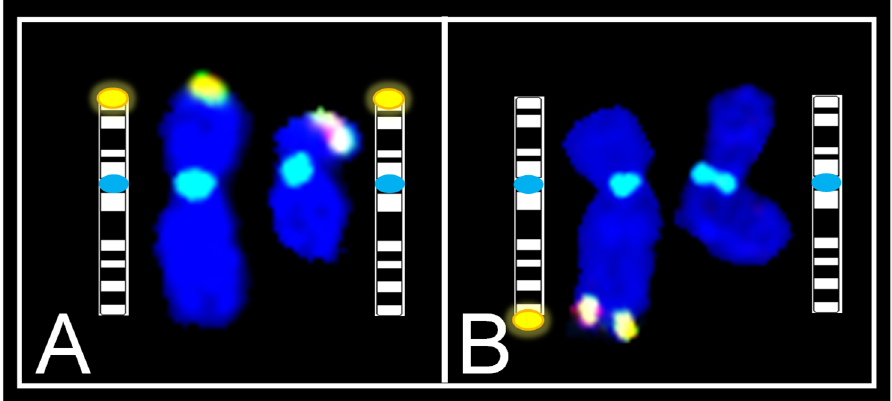
Figure 4. Photomicrographs showing normal Xq and abnormal Xq following 3 consecutive hybridizations of metaphase spreads. Each frame contains an insert representing the magnified image with representative ideogram of chromosome X for 3 respective hybridizations. ( A1 ) First hybridization with TV mix 1 reveals a normal signal pattern for chromosomes 1 (yellow boxes) and Xp (green boxes). ( A2 ) Classified image as a result of second hybridization with SKY, validates FISH hybridizations for chromosomes X (green boxes), 1 (yellow boxes), and 2 (red boxes), while illustrating no change in spectral emission for Xq ter. ( A3 ) Third hybridization with TV mix 2 reveals a normal signal pattern for chromosomes 2 (red boxes) and Xq (green boxes). ( B1 ) First hybridization with TV mix 1 reveals a normal signal pattern for chromosomes 1 (yellow boxes) and Xp (green boxes). ( B2 ) Classified image as a result of second hybridization with SKY, validates FISH hybridizations for chromosomes X (green boxes), 1 (yellow boxes), and 2 (red boxes), while illustrating no change in spectral emission for Xq ter. ( B3 ) Third hybridization with TV mix 2 reveals a normal signal pattern for chromosomes 2 (red boxes), one chromosome X with a normal signal pattern for Xq (green box) and one chromosome X with a deletion of Xq ter (green circle). White arrows indicate deletion of Xq terminal region.